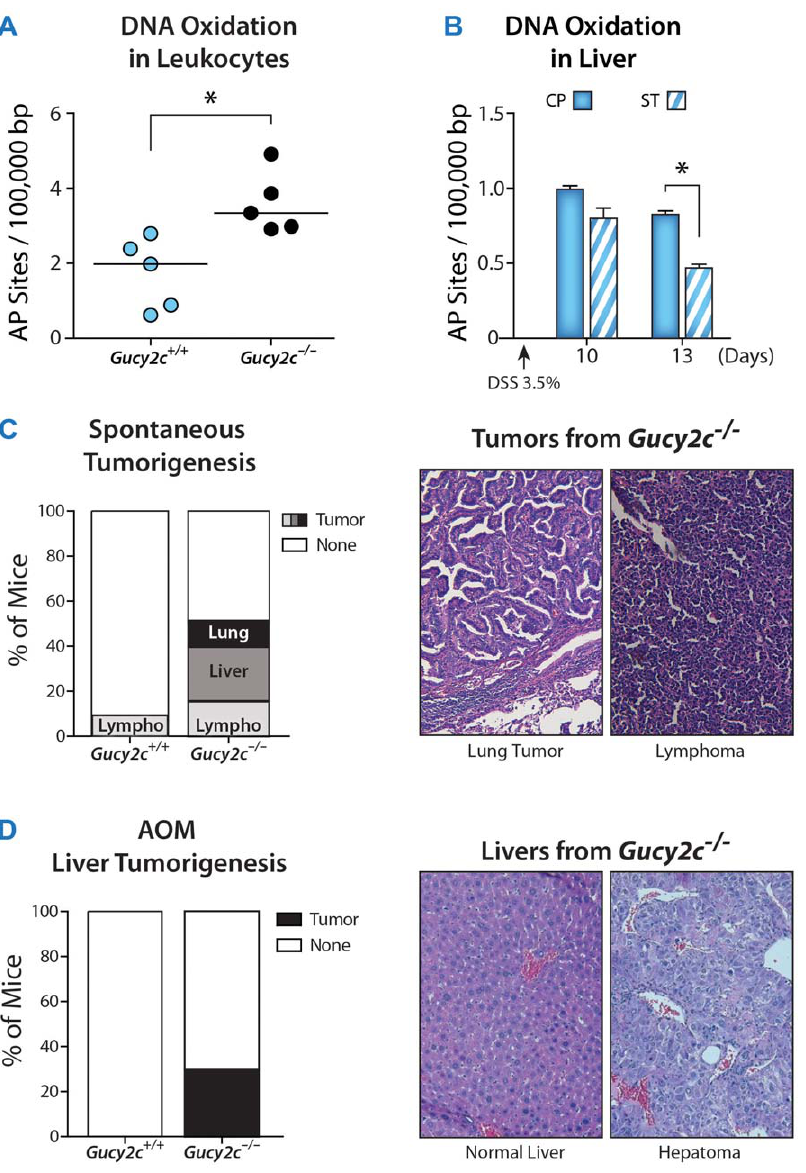
Figure 5. GUCY2C modulates systemic genotoxicity and tumorigenesis. ( A ) Eliminating GUCY2C increases basal DNA oxidation in leukocytes. Each point represents one mouse. ( B ) Oral ST supplementation decreases DSS-induced hepatic genotoxicity. Gucy2c + / + mice were preconditioned with oral ST for 6 d, and then treated with 3.5% DSS for 7 d, followed by quantification of DNA oxidation in liver on days 10 (n $ 5) and 13 (n $ 2; 3 and 6 d post-DSS exposure). Data represent mean 6 SD. ( C ) Gucy2c 2 / 2 mice exhibited a higher incidence of spontaneous tumors comparing with age-matched 2-year-old Gucy2c + / + mice (n $ 14, p=0.02). ( D ) The carcinogen AOM induced hepatoma in Gucy2c 2 / 2 , but not Gucy2c + / + , mice (n $ 10, p=0.04). C and D are analyzed by two-sided Fisher’s exact test. *, p ,